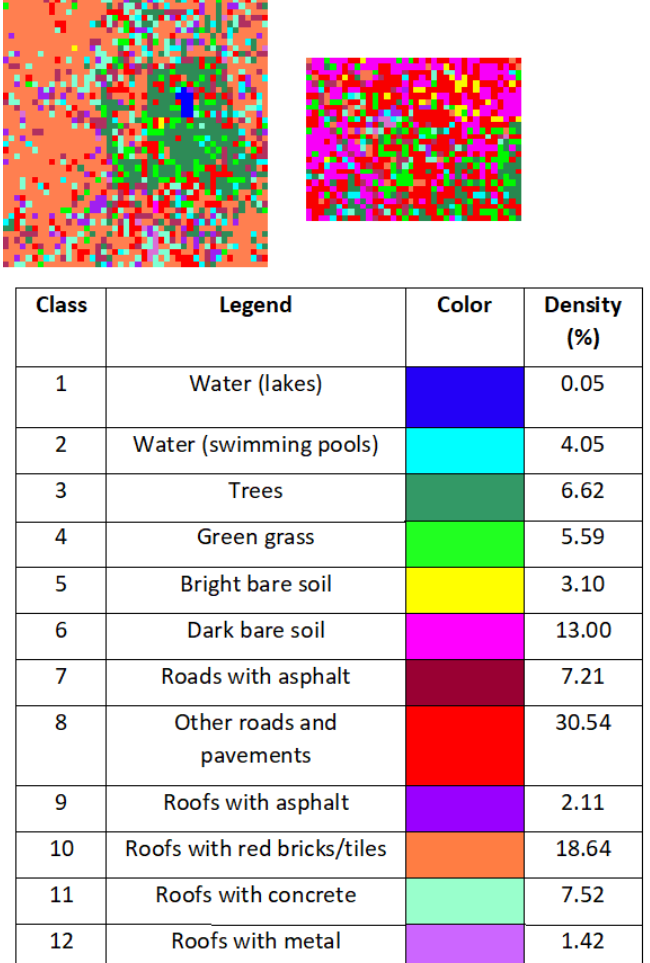
Figure 6. The 60-m classification map obtained from the 4-m one over the Retiro Park ( top left ) and the UAM ( top right ), with the legend and the density of each class in percentage ( bottom